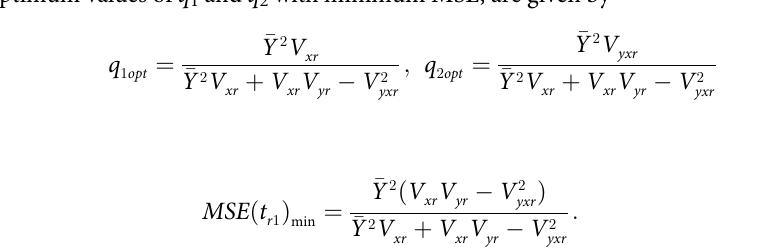
ffiffiffiffiffiffiffiffiffiffiffiffi p V V yr xr